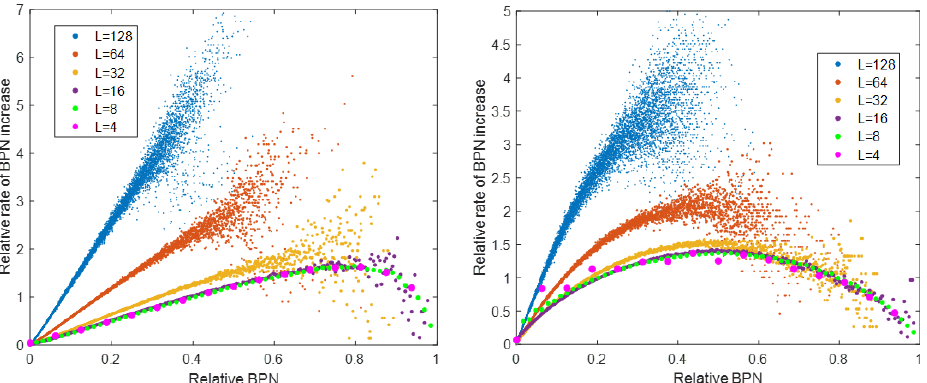
Figure 8. The BPN increase rates for BPP 20% and the pixel block side length increasing from 4 to 128 in a binary fashion for randomised data and for original data.